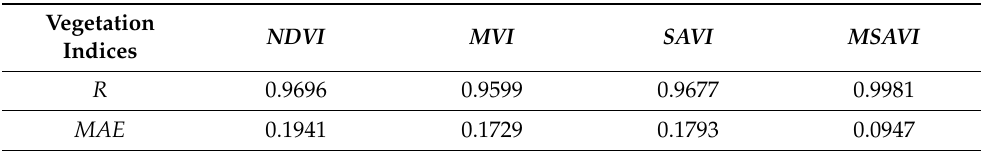
Table 4. Correlation coefficient ( R ) and mean absolute error ( MAE ) of image-based forest FVC from different vegetation indices with ground forest FVC .